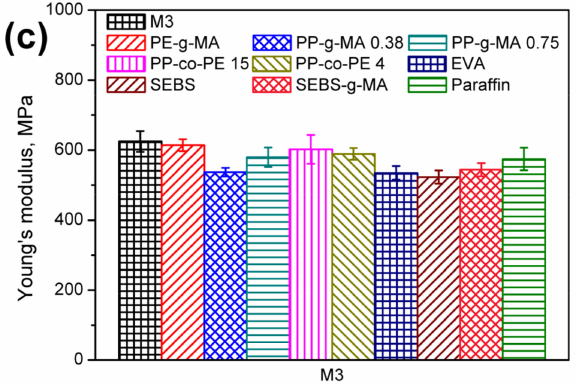
Figure 12. Young’s modulus of compatibilized ( a ) M1, ( b ) M2, and ( c ) M3